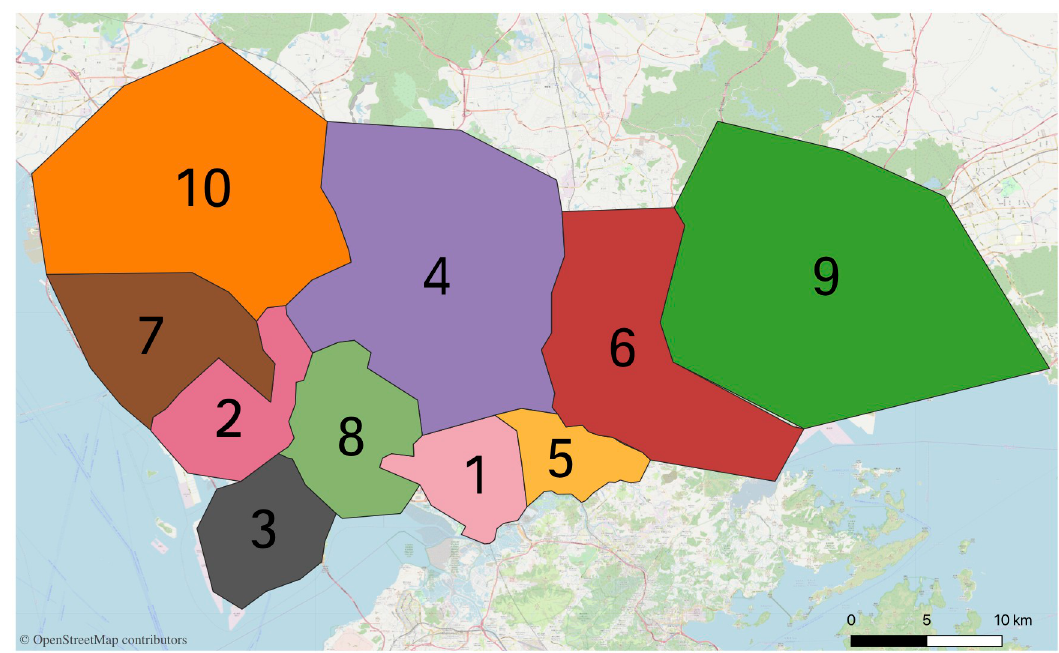
Fig 7. Order zones are adjusted and numbered.